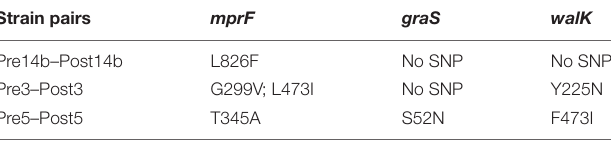
TABLE 2 | Amino acid changes in mutant S. aureus strains. Strain pairs mprF graS